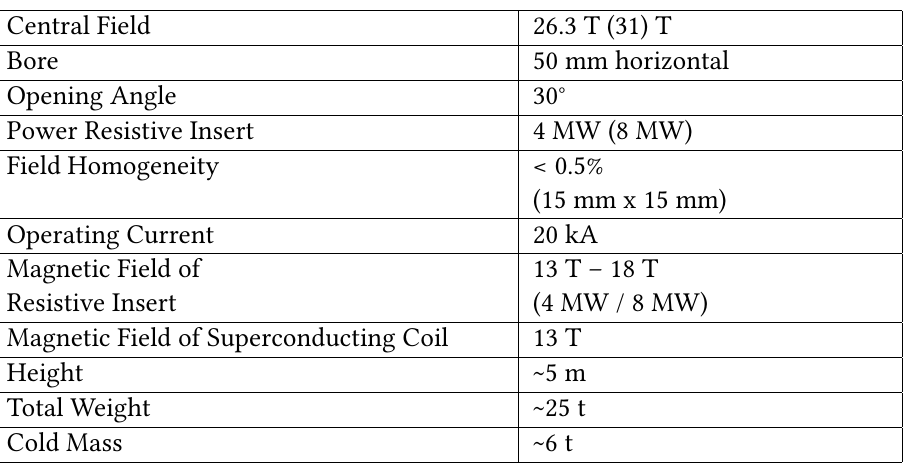
Table 1: Hybrid magnet system operating